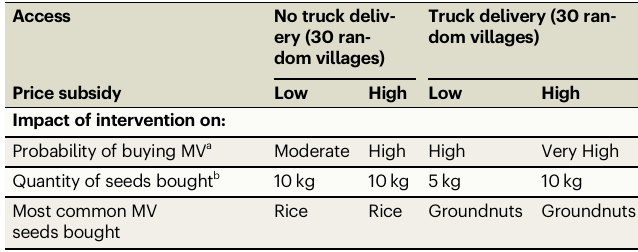
Table 1 | Changes in the uptake of modern seed varieties induced by experimental variations